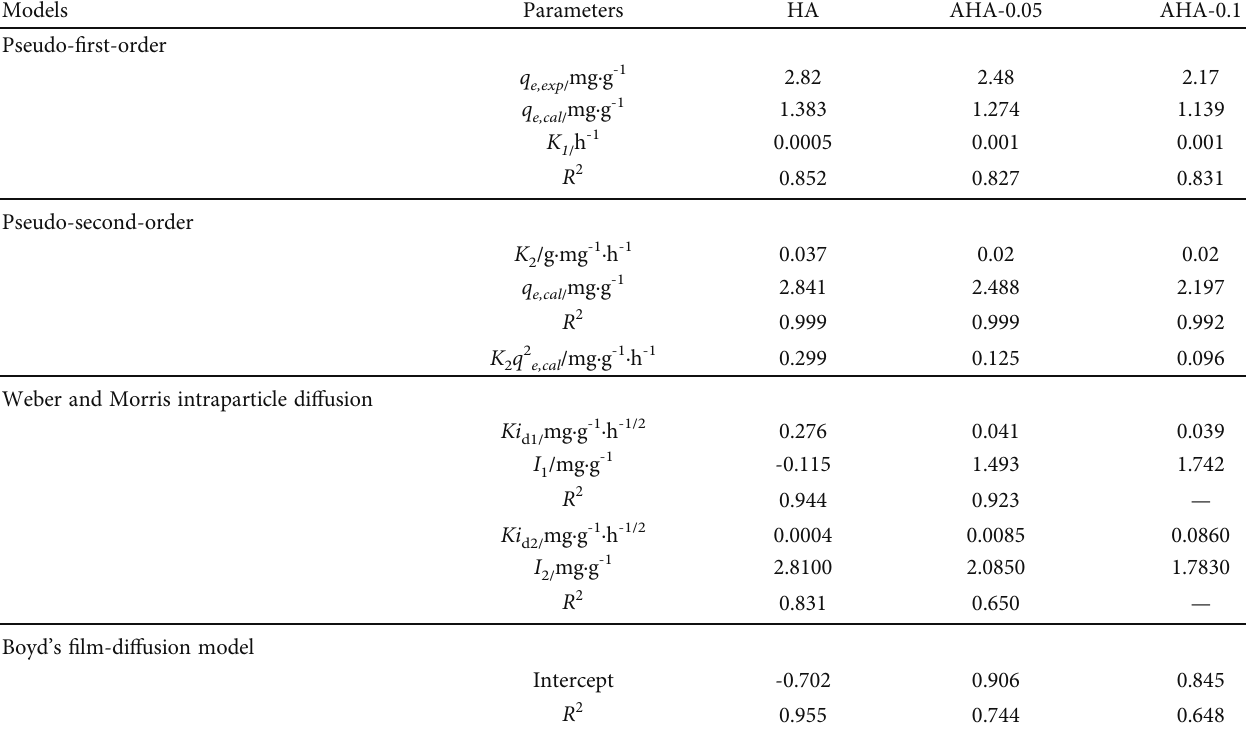
Figure 2: (a) E ff ect of contact time on the adsorption of TC in which the initial concentration was 20mg/L (insert is the removal e ffi ciency to q under di ff erent contact time; (c) ratio of q of TC under di ff erent contact time); (b) ratio of q t e parameters of di ff erent models (model 1: pseudo-second-order model; model 2: Weber and Morris intraparticle di ff usion model; model 3: Freundlich model). Table 1: Parameters of the kinetic models for the adsorption of TC by HA and AHA samples.